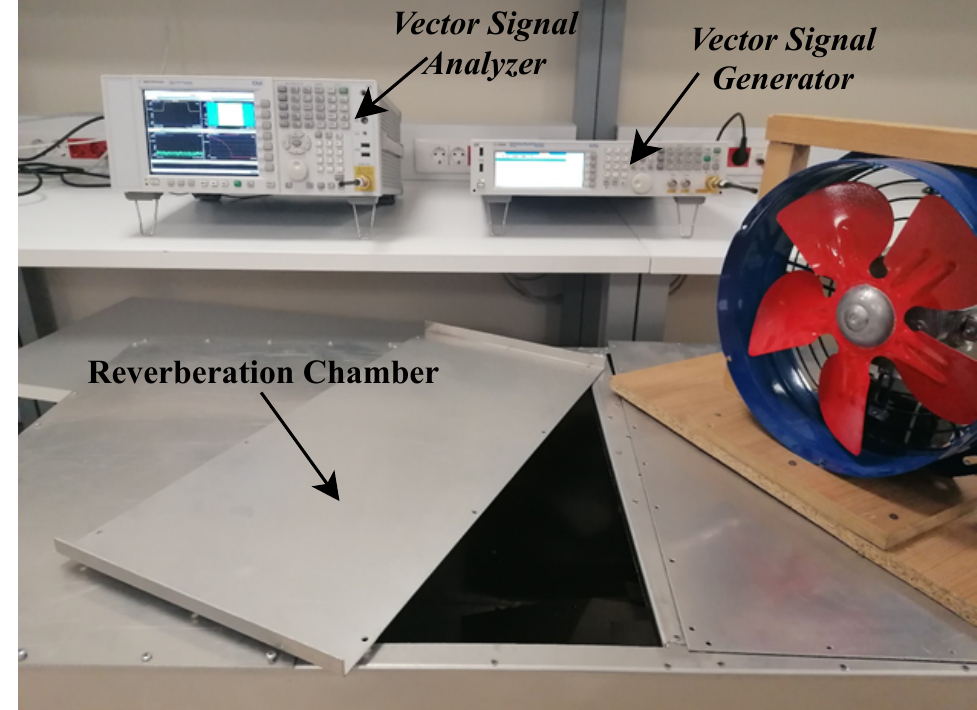
Figure 4. Laboratory equipment